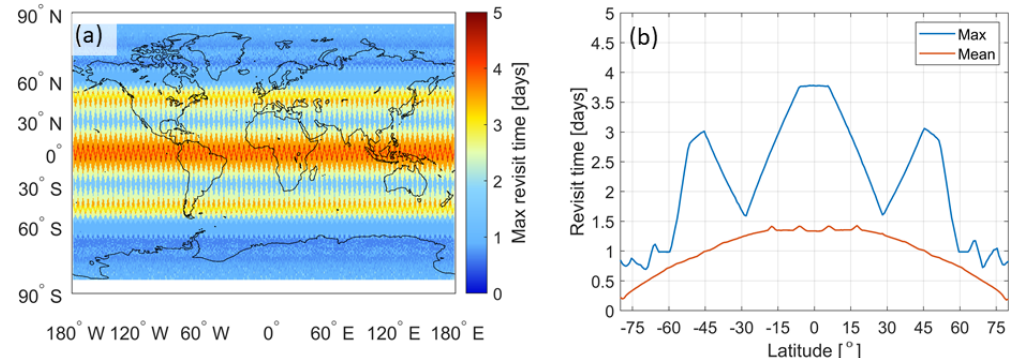
Figure 4. (a) WIVERN maximum (i.e., the worst-case scenario) revisit time for a 15 + 1 / 5d orbit. (b) The red dotted and blue continuous lines correspond to the latitude-averaged mean and maximum revisit time, respectively, as a function of latitude. Note a mean revisit time of 1.5d in the tropical band and of less than 1d above 50 ◦ latitude. Globally, the mean revisit time is roughly daily.